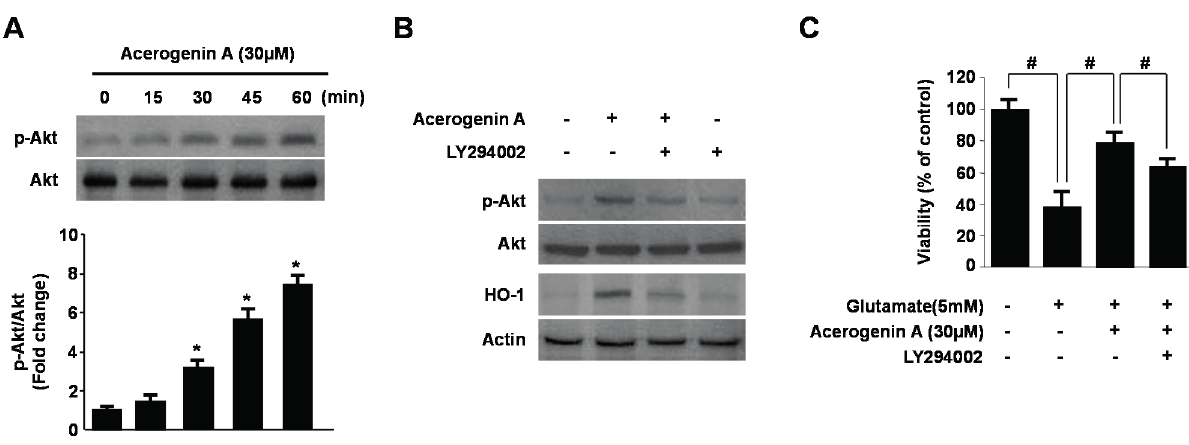
Figure 5. Effects of acerogenin A-induced HO-1 expression through the phosphatidylinositol 3-kinase (PI3K)/AKT cascade. HT22 cells were treated with acerogenin A (30 μ M) for the indicated times ( A ). HT22 cells were pre-incubated with or without 10 μ M LY294002 for 1 h and then incubated in the absence or presence of 20 μ M of acerogenin A for 60 min (p-AKT) or 12 h (HO-1) ( B ). HT22 cells untreated or treated with acerogenin A (30 μ M) in the presence or absence of LY294002 (10 μ M) for 12 h were exposed to 5 mM glutamate for 12 h ( C ). Western blot analysis was performed, and representative blots of three independent experiments are shown. Data are presented as the mean ± SD values of three independent experiments. * p < 0.05 vs . control. # p <